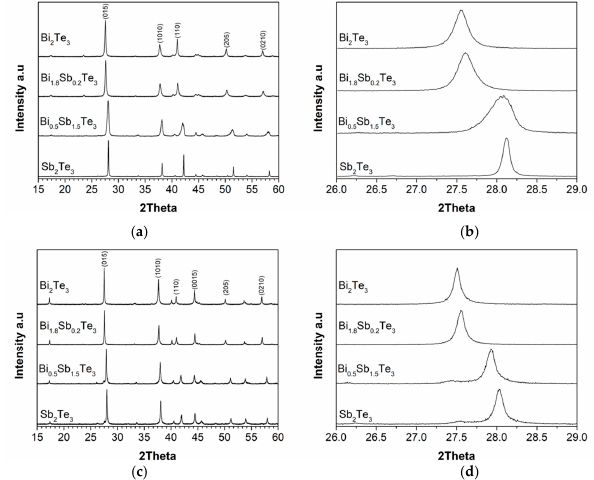
Figure 1. XRD powder patterns of powder Bi 2–x Sb x Te 3 samples: ( a ) in the 2 θ range of 15–60; and ( b ) 2 θ range of 26–29, focusing on the peak with the miller indices of (015), showing the shift of the peak position towards larger 2 θ values due to shrinking lattice by substituting Bi with Sb. ( c , d ) The XRD patterns of the sintered pellets measured perpendicular to the pressing direction. The crystalline phases are indexed to Bi 2 Te 3 (ICDD: 01-082-0358) (for x = 0) and Sb 2 Te 3 (ICDD: 01-071-0393) (for x = 2) with rhombohedral crystal structure.